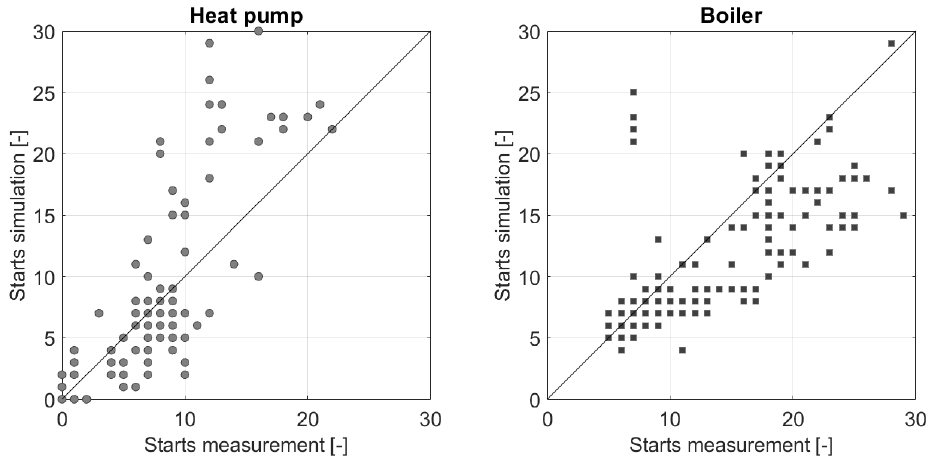
Figure 21. Daily number of starts of the heat pump ( left ) and the boiler ( right ) in simulation and measurement.